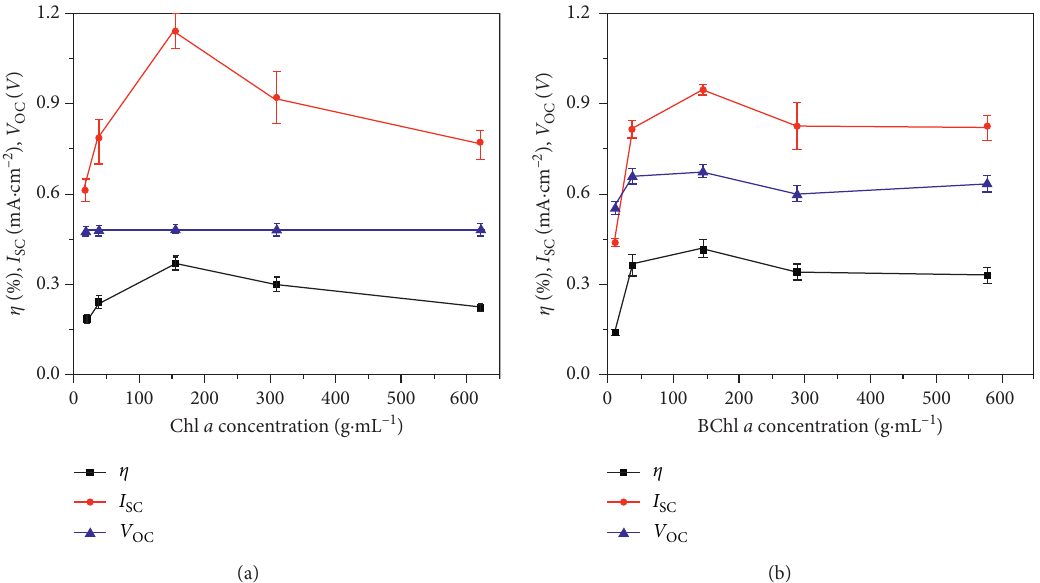
Figure 2: Photoelectric parameters of different concentrations of NA56 (a) and CQV97 (b) pigment extract-sensitized solar cells (standard deviation is the calculate values based on the measurements of three parallel solar cells).